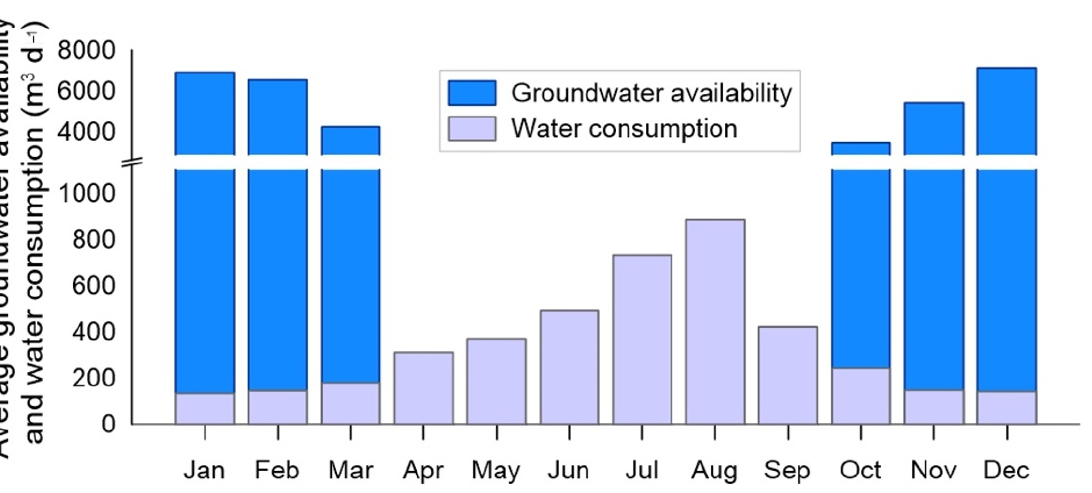
Figure 11. Comparison between the monthly average values of groundwater availability and water consumption [24].